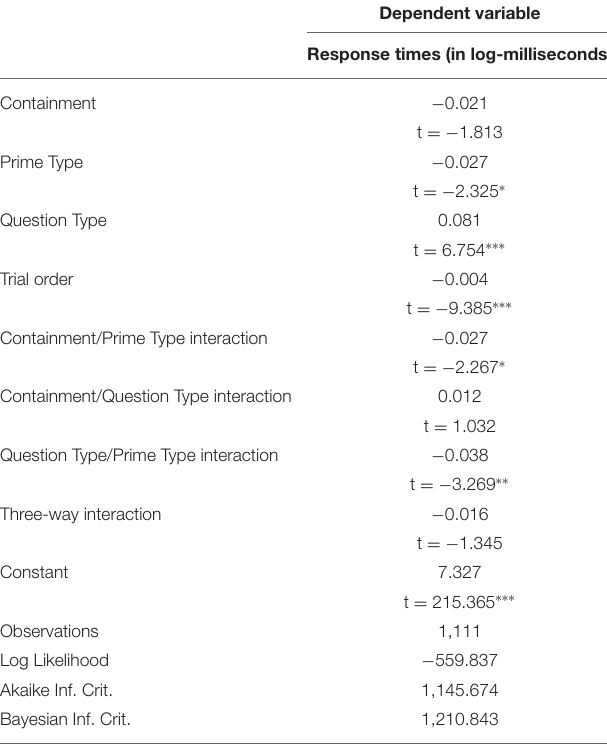
TABLE 6 | Regression analysis of response-times in Experiment 1.